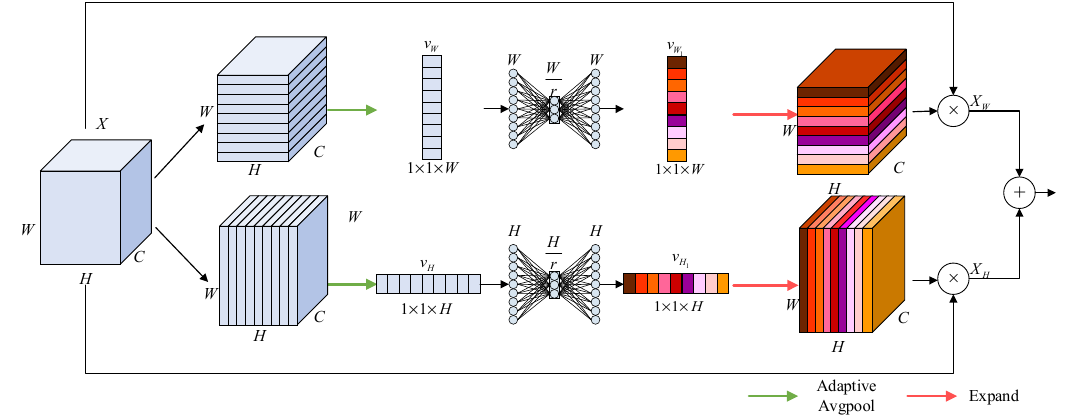
Figure 5. Strip Attention Module.